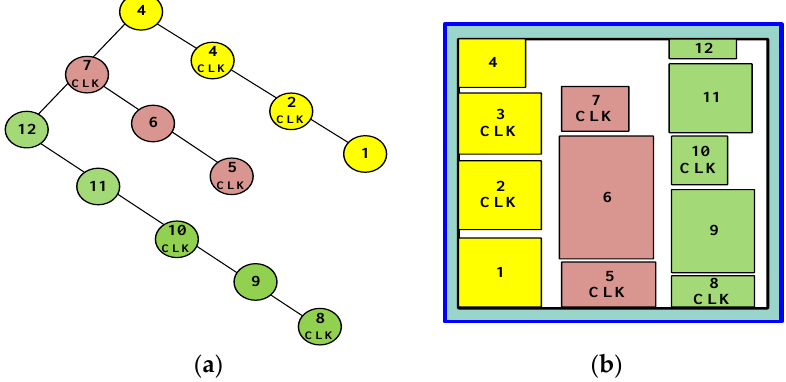
Figure 1. ( a ) Floorplan representation, and ( b ) placement of modules in the layout.